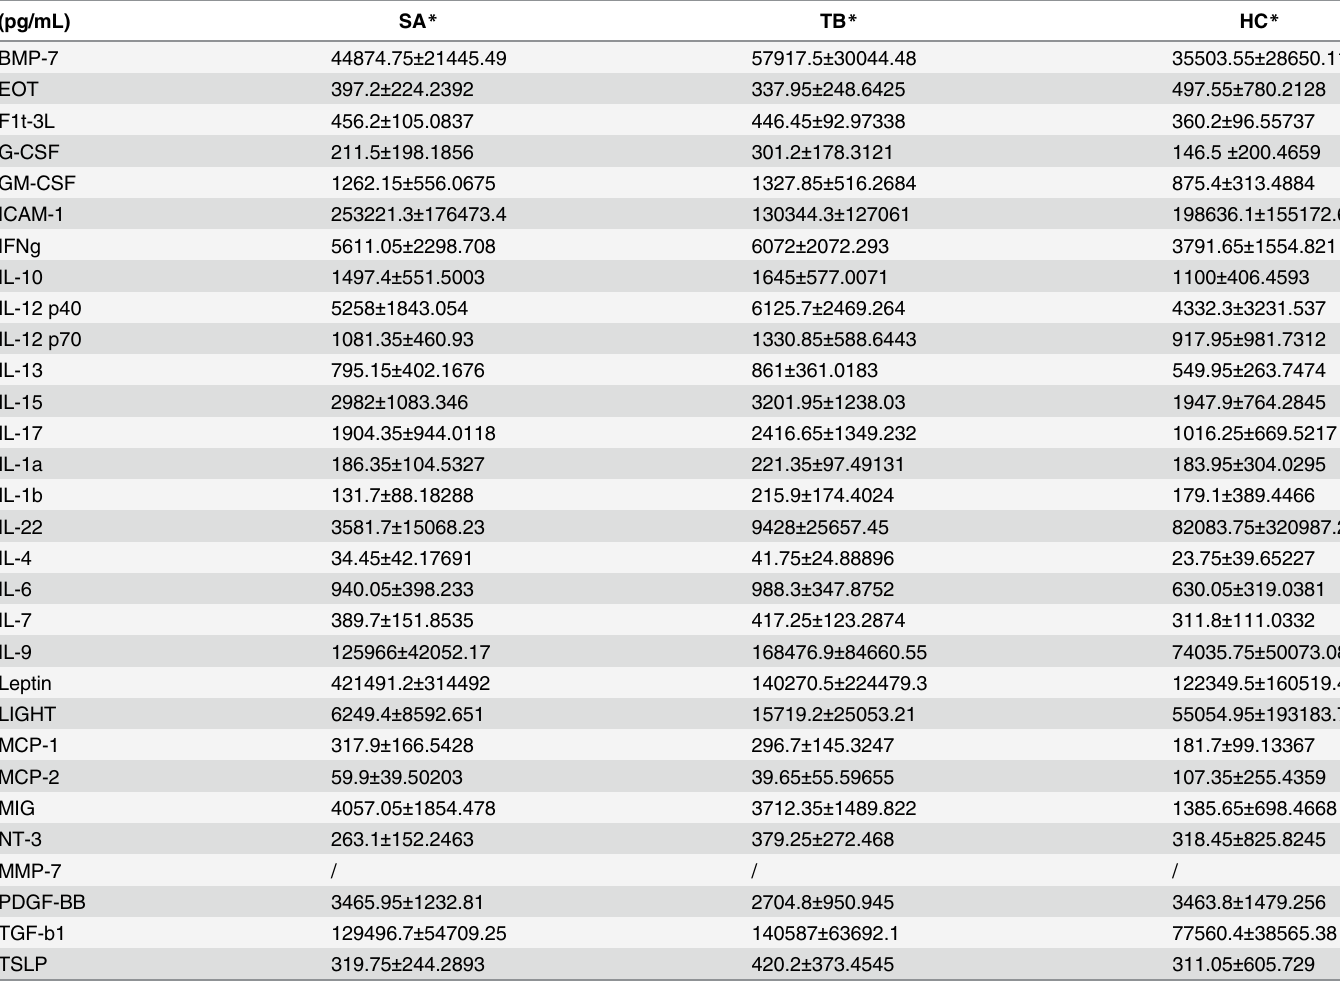
Table 3. Serum protein levels in the SA, TB, and HC groups, as measured by protein microarray analysis (mean ±